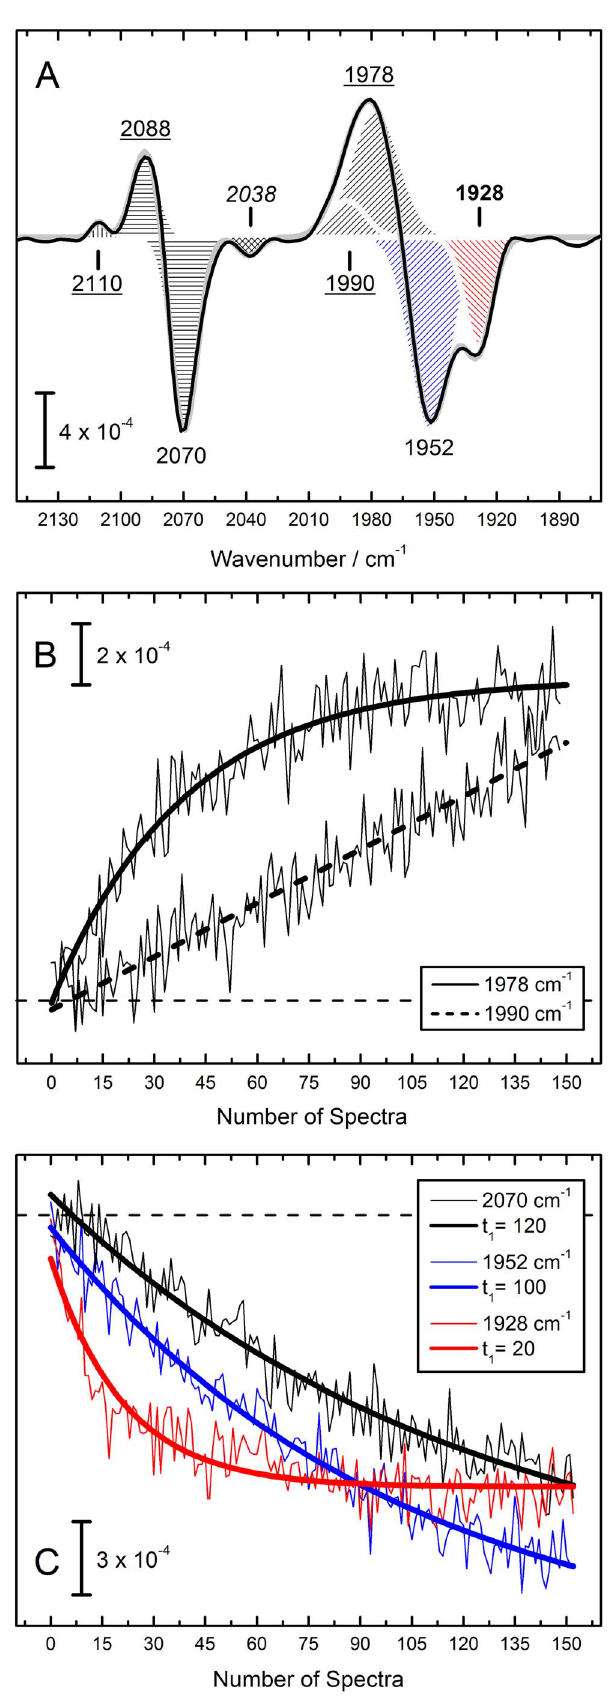
Figure 3. H 2 O 2 IR difference spectrum of HypCD MC . (Fig. 3A) Negative features represent the as–isolated state (1928 and 1952 cm 2 1 for CO in red and blue hatch, respectively, and 2070 cm 2 1 for CN 2 ), positive features are attributed to the oxidized, instable Fe(III)–(CN) 2 CO state with 1978/1992 cm 2 1 attributable to CO and 2088 and 2110 cm 2 1 attributable to the CN 2 ligands [24]. A new band arises at 2038 cm 2 1 (cross hatch). (Fig. 3B) While the contribution at 1978 cm 2 1 exponen- tially increases after contact of the sample with H 2 O 2 , the band at 1990 cm 2 1 obeys a rather linear kinetic behavior. (Fig. 3C) The previously identified contributions at 1952 and 2070 cm 2 1 vanish simultaneously [24], however, the peak at 1928 cm 2 1 showcases a four to five times faster absorption decay. All kinetics are plotted in ‘Number of Spectra’ to avoid misinterpretation of temporal